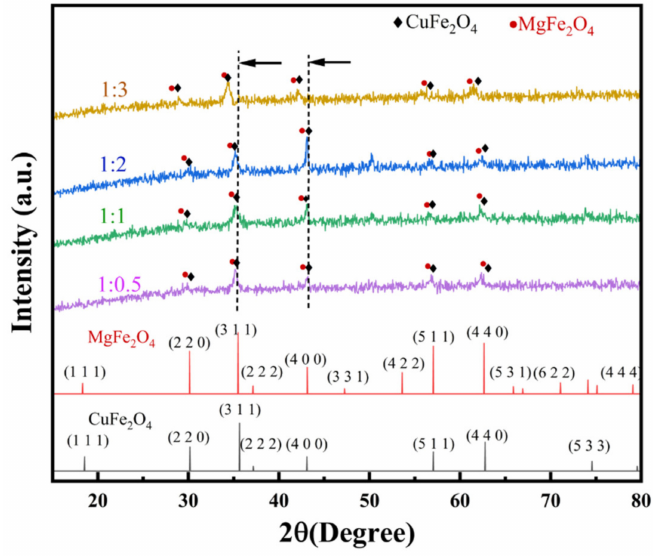
Figure 3. XRD patterns of all CuFe 2 O 4 /MgFe 2 O 4